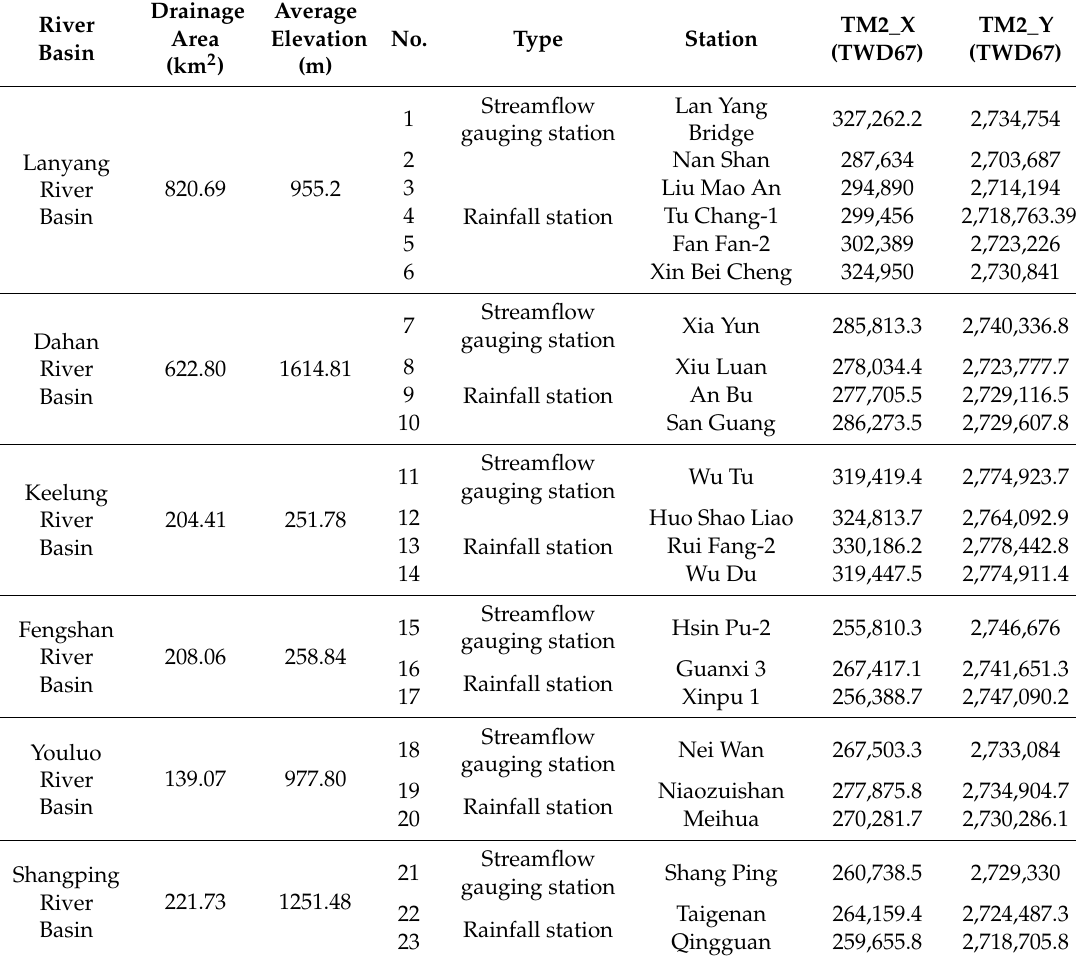
Table 2. Information for the rainfall station and streamflow gauging station in northern Taiwan